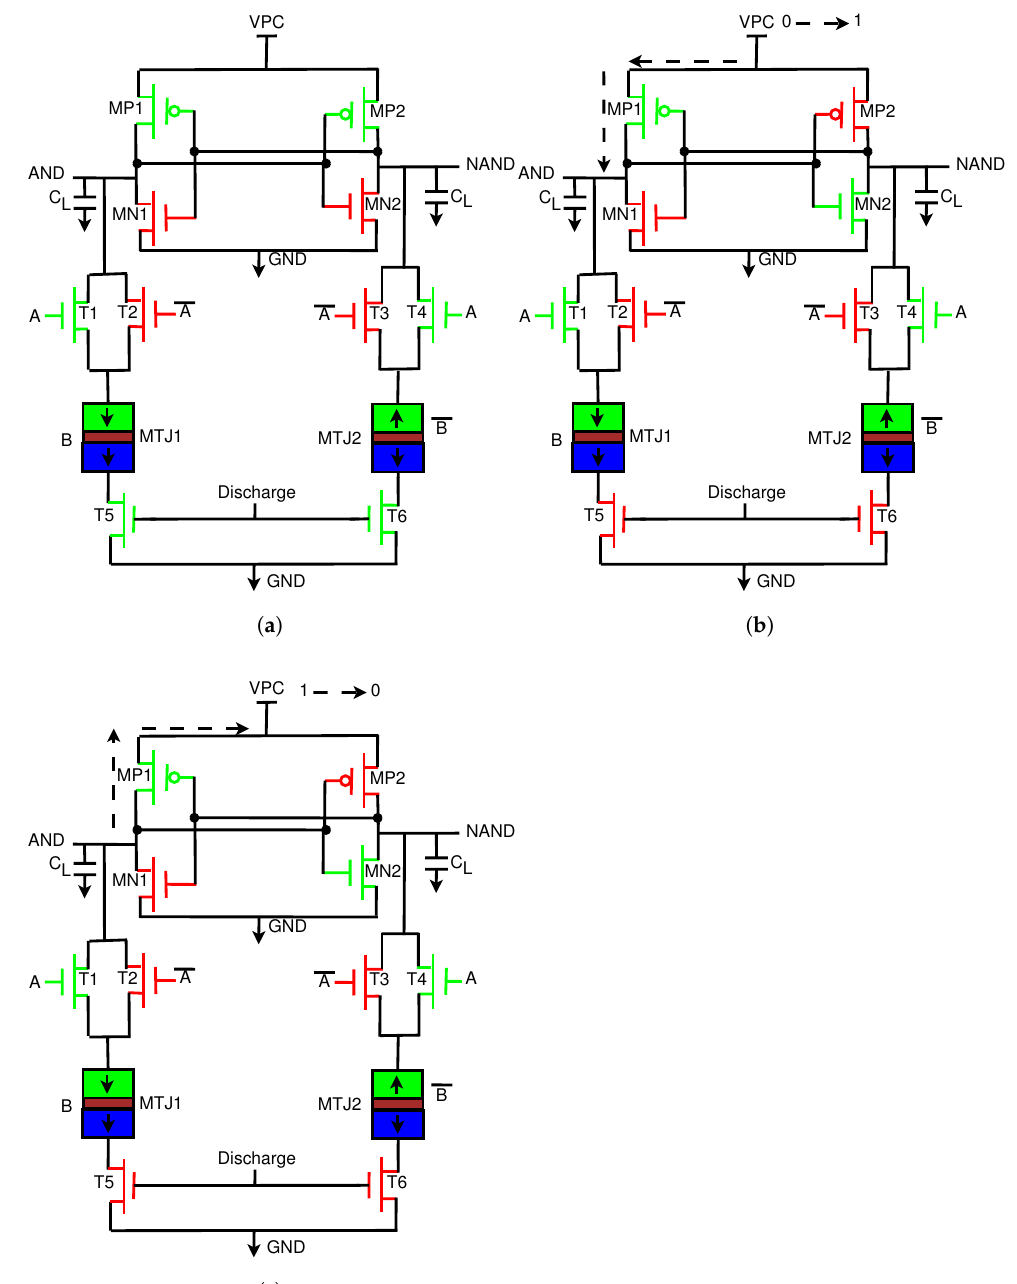
Figure 11. Operation of the proposed Energy-Efficient Adiabatic CMOS/MTJ AND/NAND gate. ( a ) Discharge stage of operation; discharge = 1, VPC = 0, A = 1, B = 1. ( b ) Evaluation phase of operation; VPC = 0 -> 1, discharge = 0, A = B = 1. ( c ) Recovery phase of operation; VPC = 1 -> 0, discharge = 0, A = B =